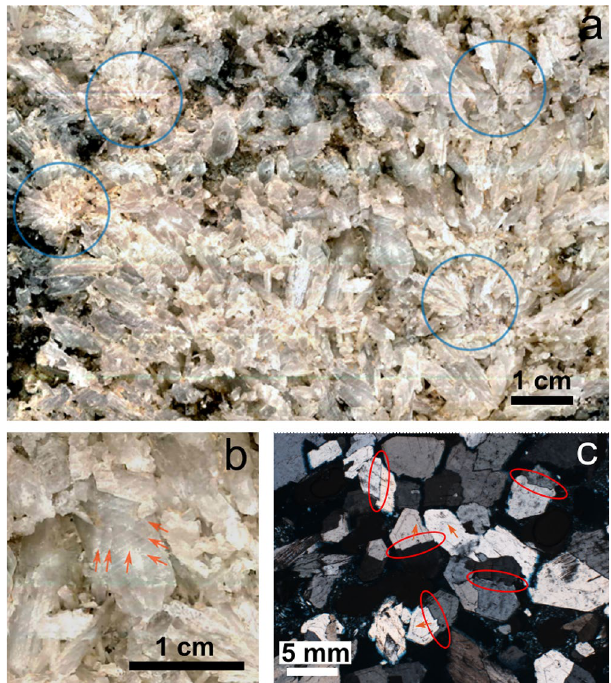
Figure 3. Crystal growth features displayed by crystals in the stromatolite-like structure. ( a ) Detail of the studied section of the stromatolite-like structure highlighting points of gypsum nucleation developing into local radial aggregates. ( b ) Gypsum crystal showing episodic growth surfaces (indicated by orange arrows). ( c ) Micrograph using polarized light of gypsum crystals showing the formation of (100) twin planes (indicated by red ellipsoids) and episodic growth surfaces (indicated by orange